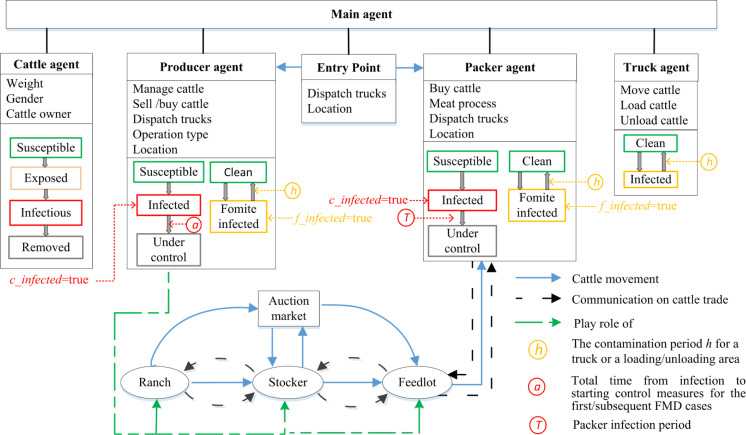
Model structure.